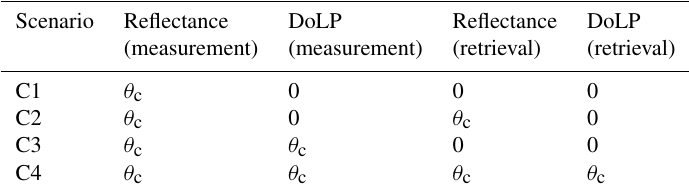
Table 3. Four scenarios of simulated uncertainties are considered in the synthetic data and retrievals. C1 and C2 indicate simulated errors with a correlation angle of θ c added to synthetic reflectance data. C1 assumes the correlation property is unknown and no correlation is considered in the cost function model, but C2 assumes the correlation as in the simulated errors is known. This is also the case for C3 and C4, which considered correlated uncertainty in both reflectance and